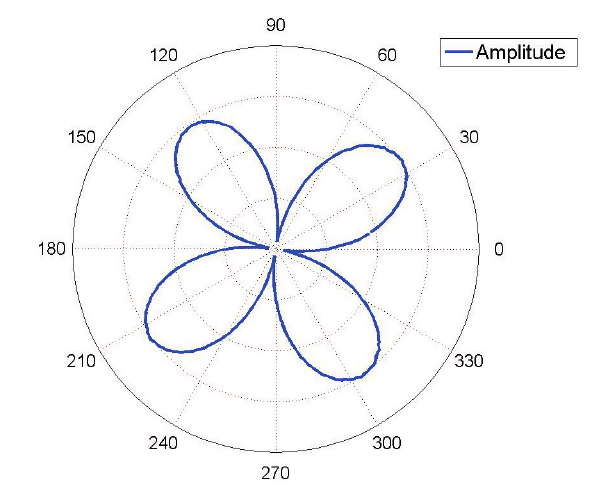
Figure 16. The amplitude curve measured by a laser Doppler